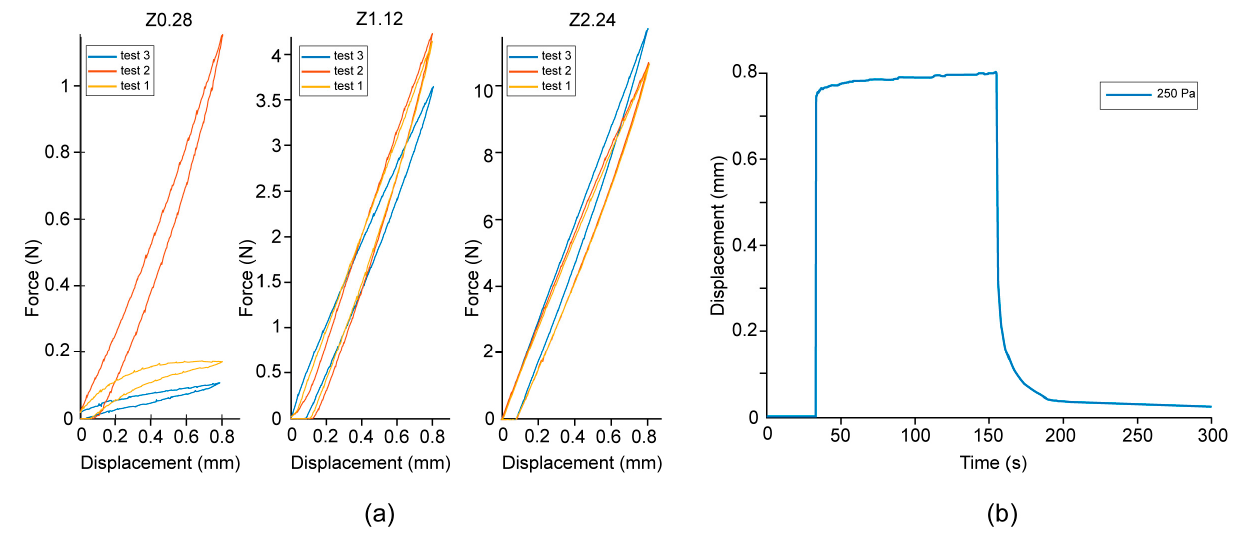
Figure 11. Results from the spring-reinforced diaphragm tests. ( a ) The force displacement curves for the three different prototypes: Z0.28 (left), Z1.12 (middle), and Z2.24 (right). Note the different scaling of the y -axis. ( b ) Example of a time-displacement curve for the Z1.12 prototype at 250 Pa pressure.